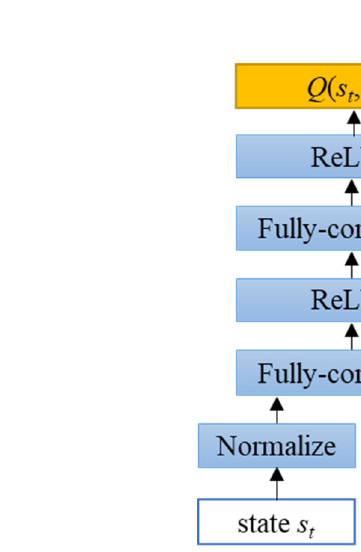
Figure 4. Policy network ( left ) and value network ( right ).